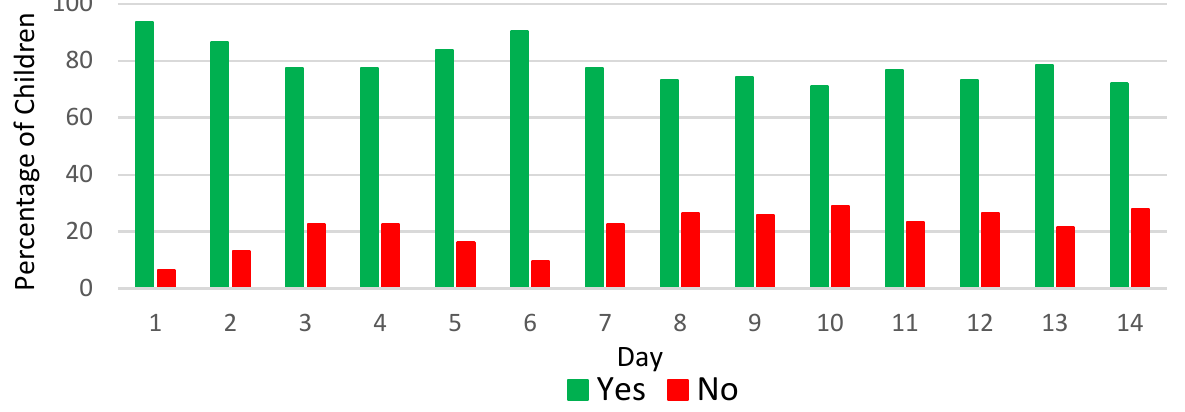
Scheme 7. Child participant (ages 1–4) survey results for the survey question: Did your child willingly open their mouth for the syringe? 3.1.7. Did the Child Spit out the Placebo? (Ages 1–4)